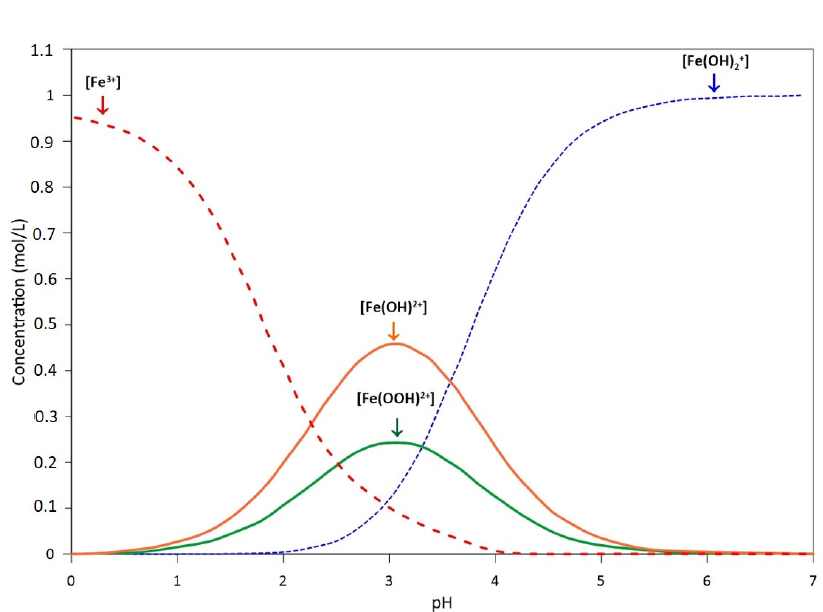
Figure 3. Chemical speciation of iron in water. Red line: [Fe 3+ ] v/s pH; blue line: [Fe(OH) 2+ ] v/s pH; green line [Fe(OOH) 2+ ] and orange line: [Fe(OH) 2+ ]. Arrows shows the maximum concentration of each species (Ocatve-Gui 5.2.0, University of Wisconsin-Madison and University of Texas, United Stated of America).